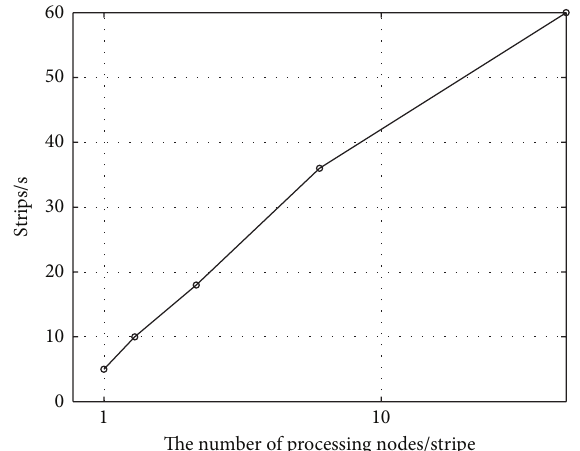
Figure 13: The effect of the number of processing nodes.